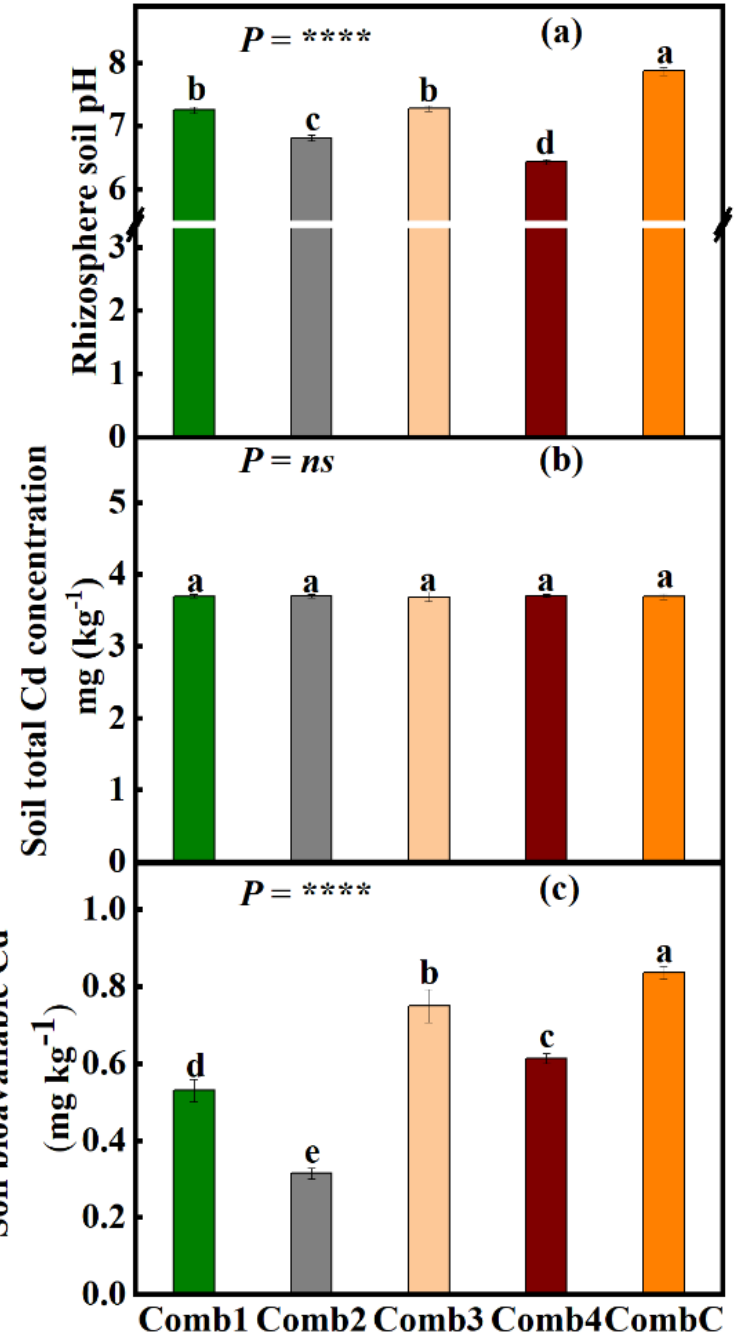
Figure 4. Effects of different combinations treatments on rhizosphere ( a ) soil pH, ( b ) soil total Cd concentrations, and ( c ) soil-bioavailable Cd at large field scale. Data (means ± SE, n = 5) followed by different subscripts denotes significant differences between combinations of treatments at p < 0.05